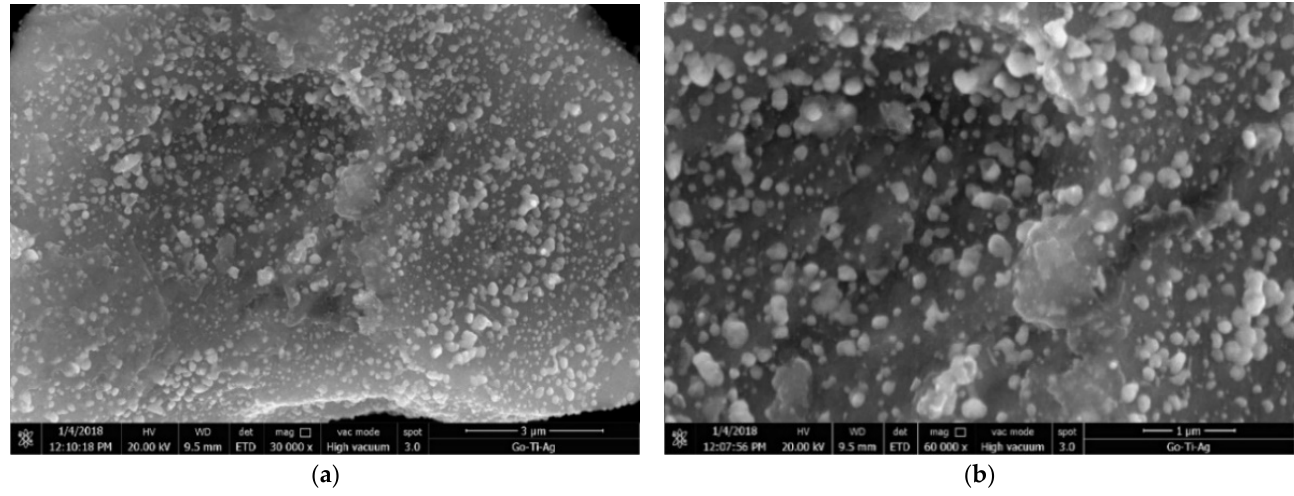
Figure 1. SEM images of GO-TiO 2 -Ag with magnifications of ( a ) 30,000× and ( b ) 60,000×.